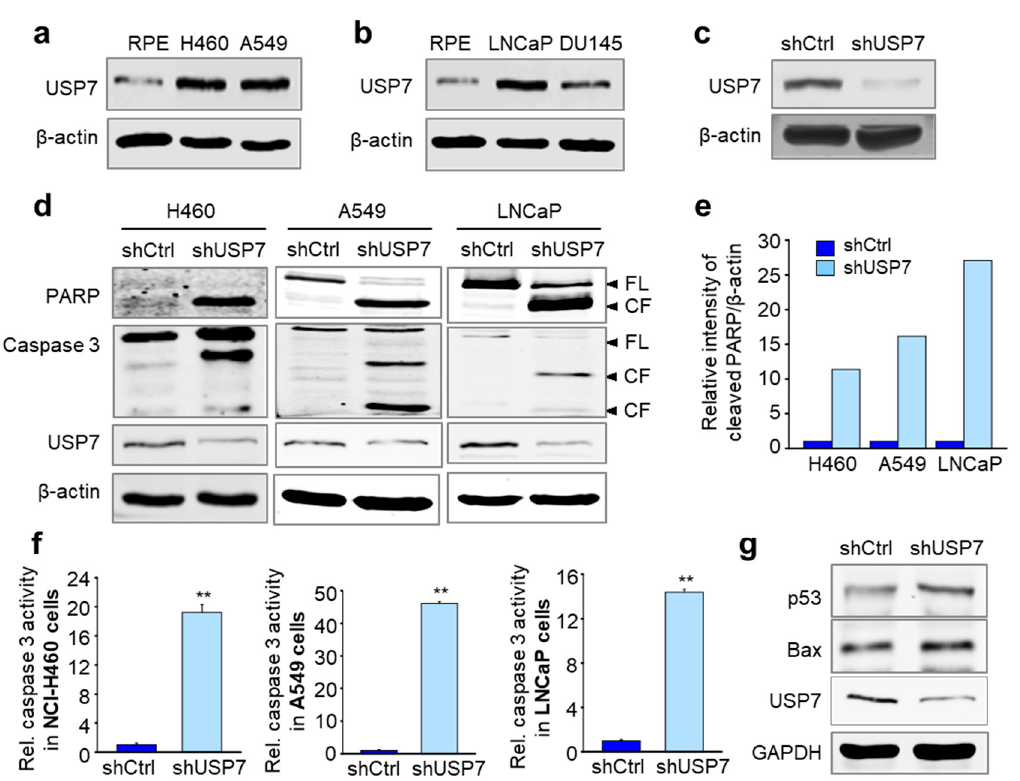
Figure 1. Depletion of USP7 induces apoptosis by activation of caspase 3 in several cancer cell lines. ( a , b ) Immunoblot analysis was performed to detect the levels of USP7. Cell lysates from non-transformed hTERT-RPE cells and lung cancer ( a ) or prostate cancer ( b ) cells were prepared to determine the levels of USP7 using a specific anti-USP7 antibody. ( c ) USP7 was depleted in LNCaP cells using USP7 shRNA. Immunoblot analysis was performed to detect the levels of USP7. ( d ) Immunoblot analysis was performed to evaluate levels of USP7, cleaved PARP, and cleaved caspase 3 in NCI-H460 (left), A549 (middle), and LNCaP (right) cells when USP7 was depleted. ( e ) The band intensity values from the immunoblots in Figure 1d were quantified using LI-COR Odyssey software (Li-COR Biosciences), normalized, and plotted. ( f ) Cell lysates from NCI-H460 (left panel), A549 (middle panel), and LNCaP (right panel) cells were subjected to a fluorometric caspase 3 activity assay. The means ± SDs (error bars) of data from at least three experiments are shown. (** p ≤ 0.01) ( g ) Immunoblot analysis was performed to evaluate the levels of p53 and Bax in USP7-depleted A549 cells.